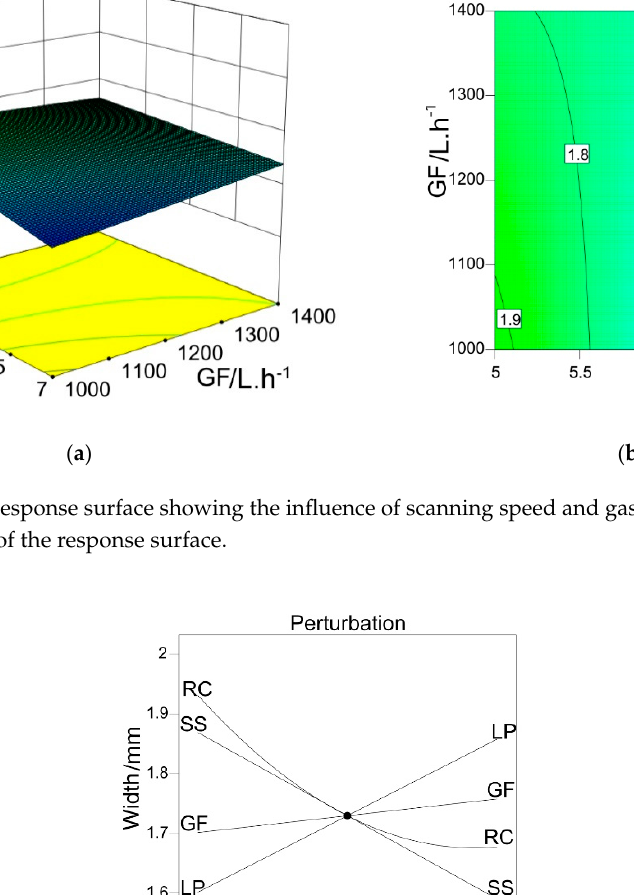
Figure 8. The influence of selected factors on clad width.